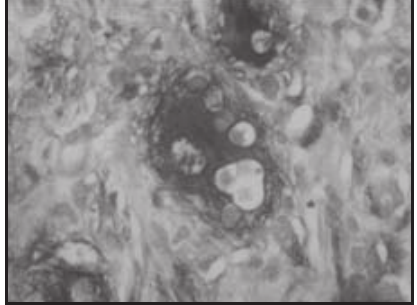
Figure 4 – S-100 expression in a large histiocyte with emperipolesis (anti-S100 antibody, DAKO, streptavidin-peroxidase